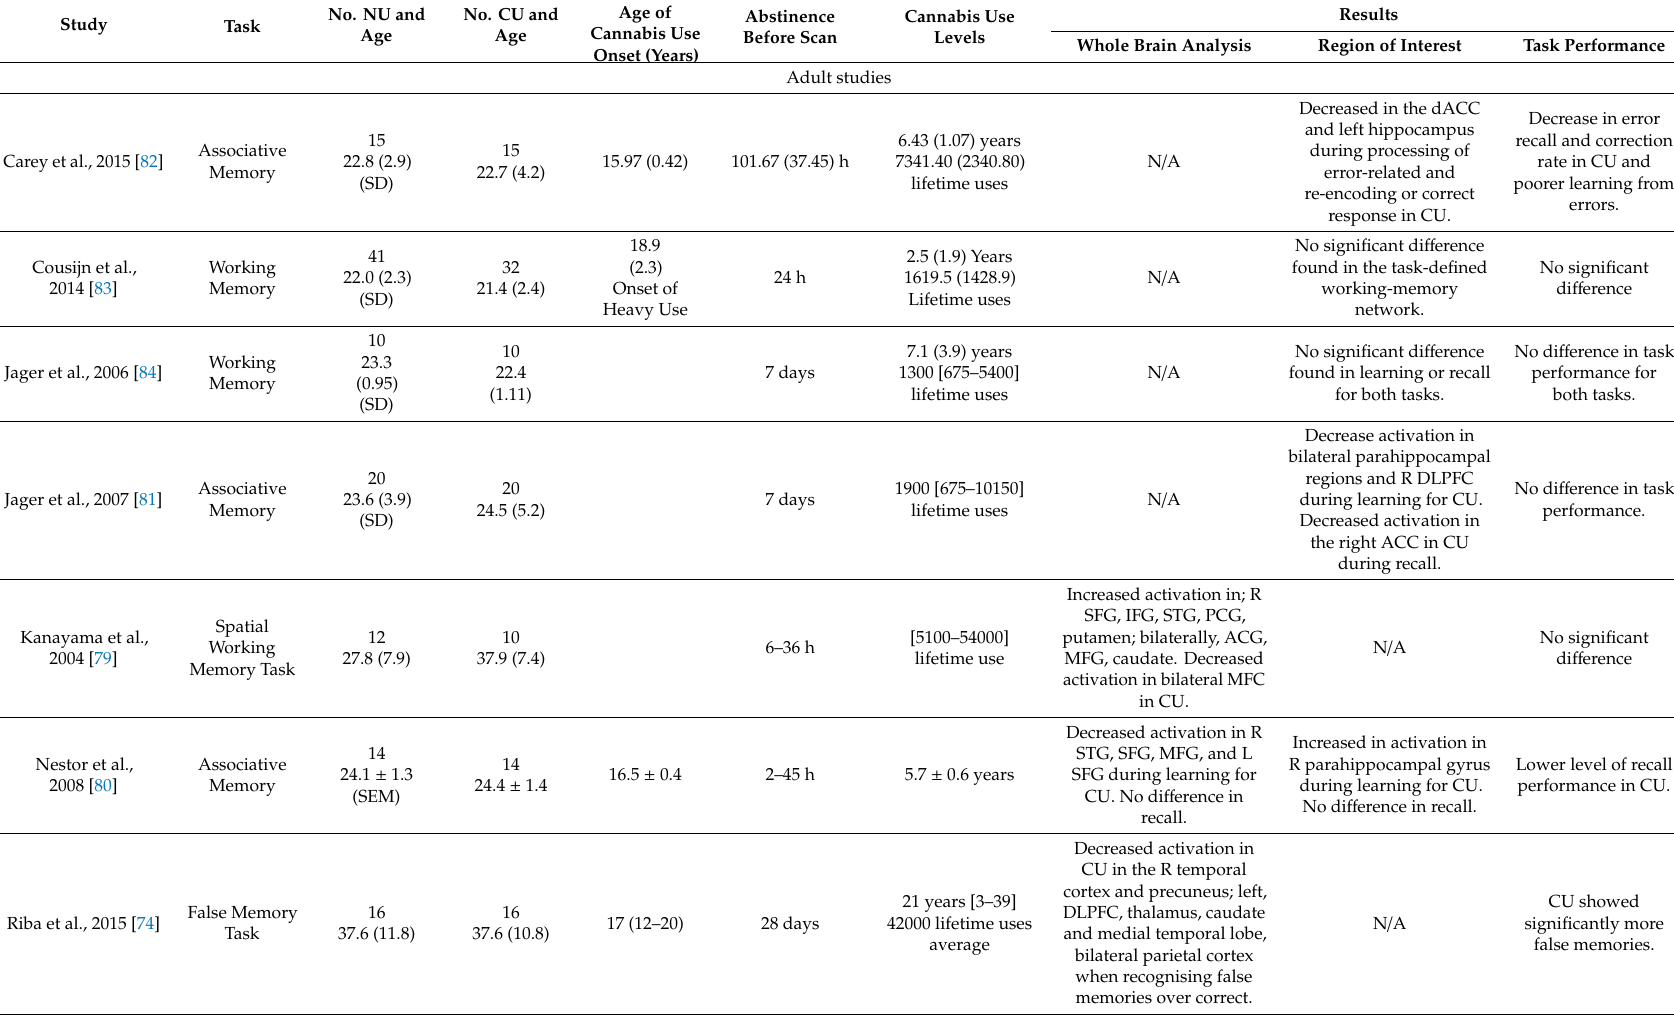
Table 1. Systematic review of cannabis users and nonusing control comparisons, using functional magnetic resonance